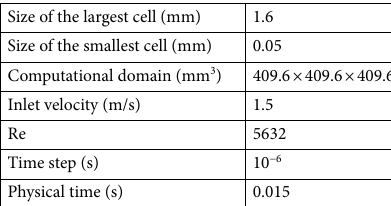
Table 1. Computational parameters of the 0° model.